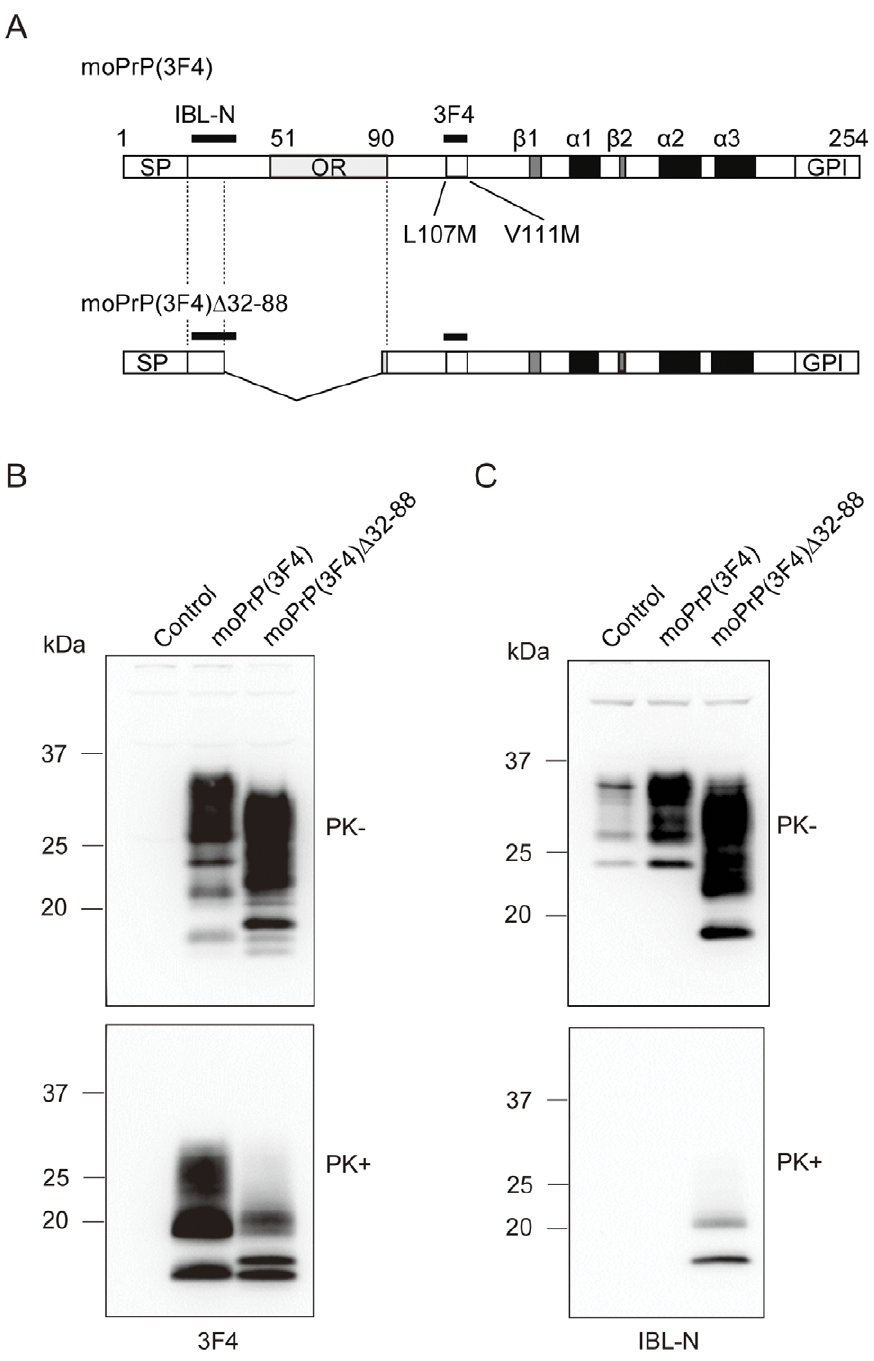
Figure 5. PK-resistant pre-OR residues 23–31 of PrP Sc D 32–88 generated in prion-infected N2a cells. (A) Schematic diagrams of moPrP(3F4) and moPrP(3F4) D 32–88. Arabic numbers represent the codon numbers. SP, signal peptide; OR, octapeptide repeat; GPI, GPI anchor signal; a , a -helix; b , b -strand. (B, C) Western blotting of N2aC24L1-3 cells transfected with control pcDNA3.1( + ), pcDNA3.1-moPrP(3F4), and pcDNA3.1- moPrP(3F4) D 32–88 using 3F4 (B) or IBL-N anti-PrP antibodies (C). The cell lysates were treated with PK at 5 m g/ml and then subjected to Western blotting. Both moPrP(3F4) and moPrP(3F4) D 32–88 were converted to the PK-resistant isoforms, moPrP Sc (3F4) and moPrP Sc (3F4) D 32–88, respectively. However, IBL-N anti-PrP antibody reacted only with the PK-resistant fragments of moPrP Sc (3F4) D 32–88. doi:10.1371/journal.pone.0043540.g005 tom of foreleg paresis, indicating that deletion of the OR region phenotypes in mice after infection with RML prions, as observed also modifies clinical signs. These unusual phenotypes were also in infected tg(PrP D OR)/ Prnp 0/0 and tg(PrP D 32–93)/ Prnp 0/0 mice. reported in infected tg(PrP D 32–93)/ Prnp 0/0 mice. This indicates However, compared to the levels of PrP Sc D OR and prion that lack of the OR region from PrP induces such unusual infectivity in the brains of tg(PrP D OR)/ Prnp 0/0 mice, the reported